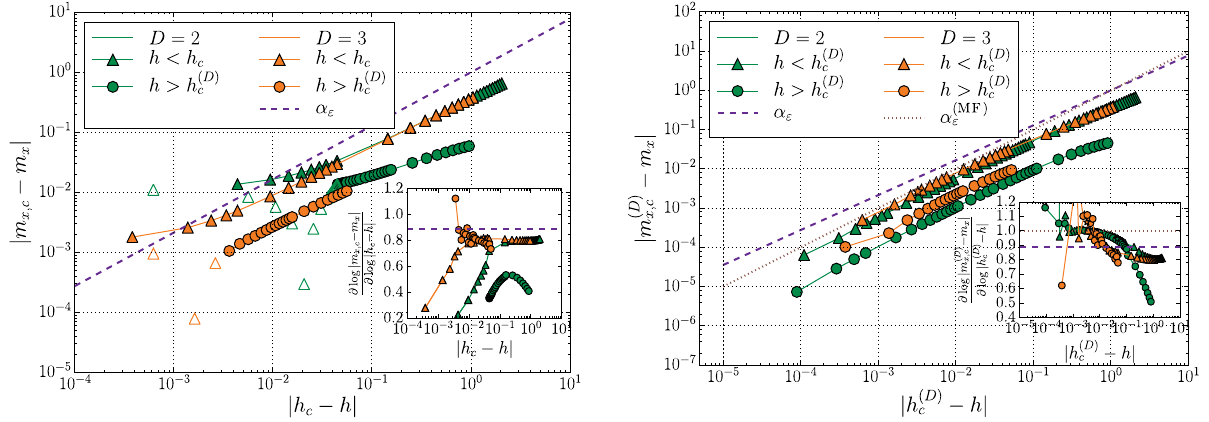
11. Analysis of the critical behavior of the m x magnetizations in the transverse-field Ising model in the vicinity of the critical point at h ¼ h c ; h z ¼ 0 as a function of the transverse field. The left-hand panel shows j m x;c − m x j as a function of j h c − h j and the right-